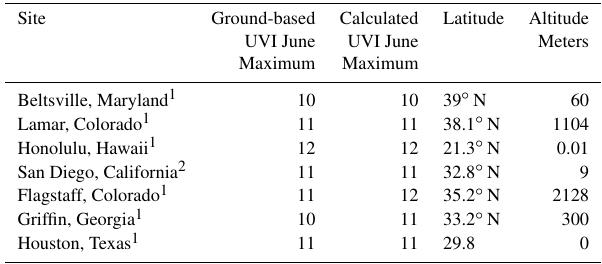
Table 1. Comparison of FP-calculated OMI UVI with ground-based